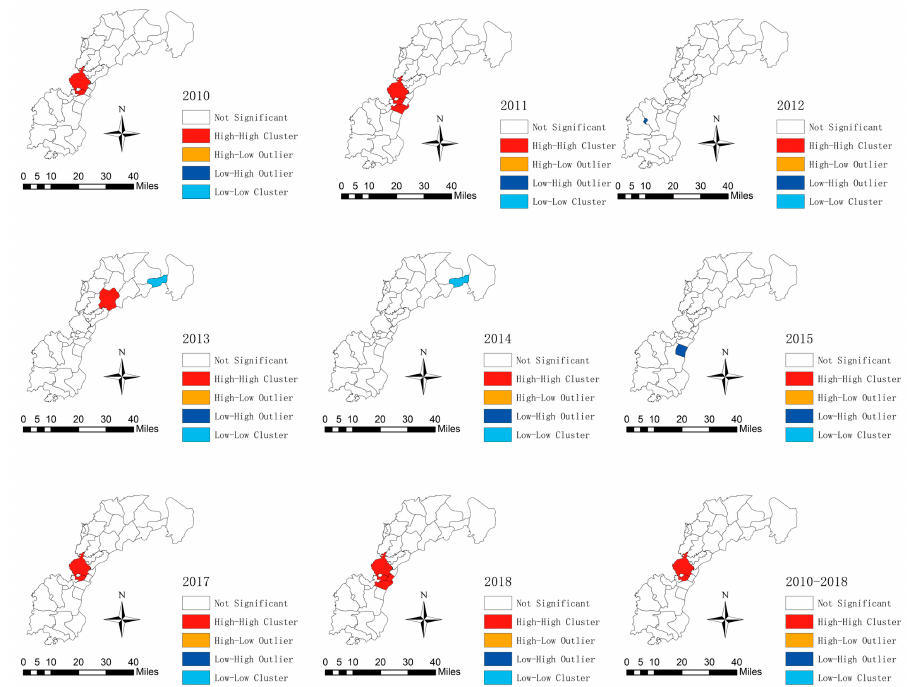
Figure 5. Local indicators of spatial association cluster maps for tuberculosis in the new urban area of Nanchang from 2005 to 2017.